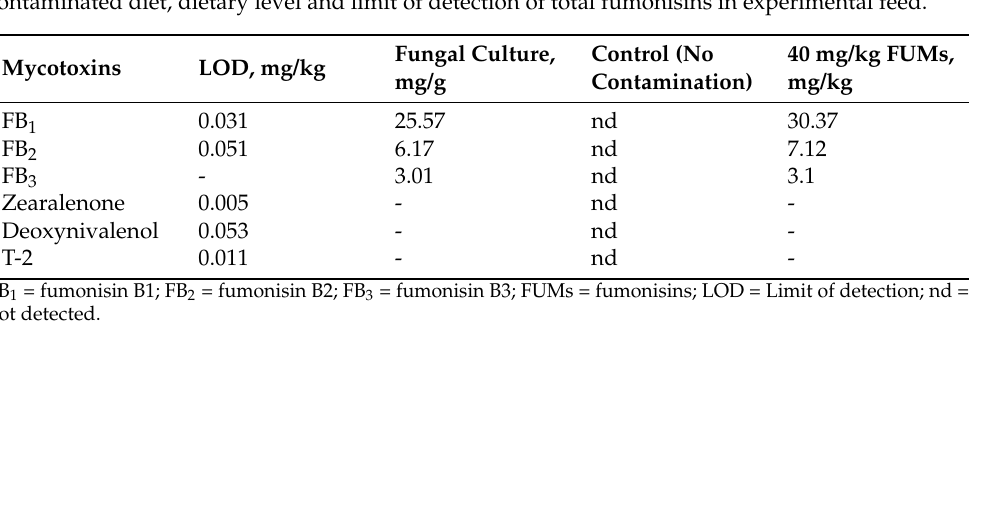
Table 2. Level of in vitro-produced (fungal culture) total fumonisins used for the formulation of contaminated diet, dietary level and limit of detection of total fumonisins in experimental